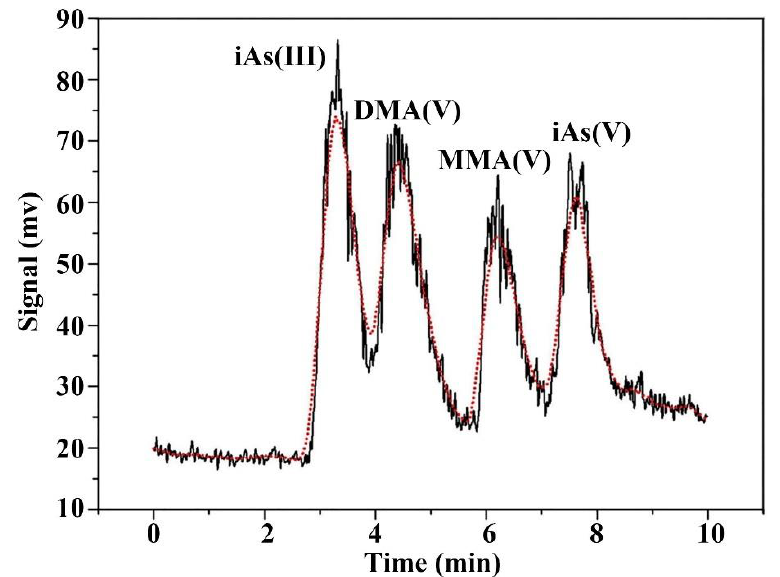
Figure 2. The chromatographic separation of four arsenic standards (iAs(III), iAs(V), MMA(V), and DMA(V)) at 100 µ g/L. Red dotted line represented the noise reduction curve measured by the embedded SAMS software.